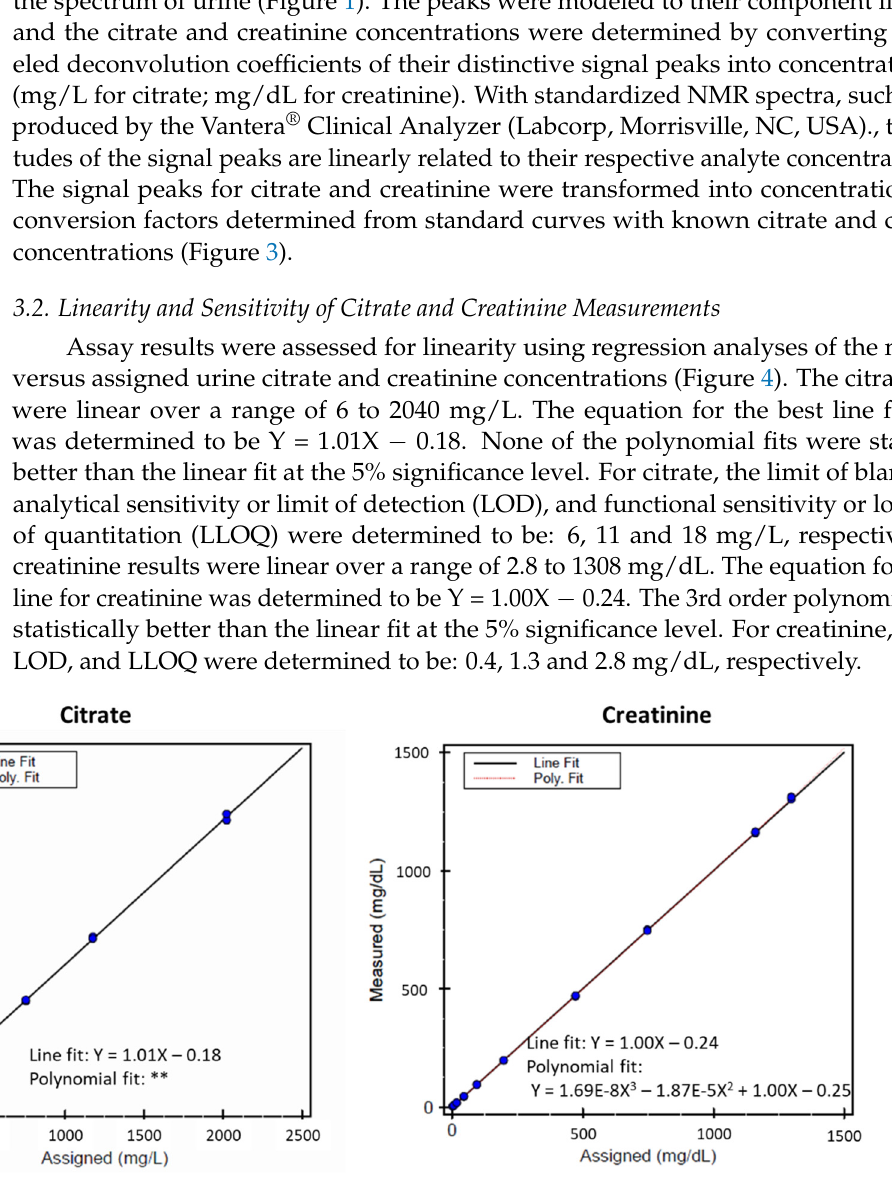
Figure 4. Linearity of NMR-measured versus assigned values of citrate ( left ) and creatinine ( right ) in the urine citrate and creatinine assay. ** After regression, no 2nd/3rd order polynomial fit was statistically better than the linear fit at the 5% significance level. Thus, only the linear fit is